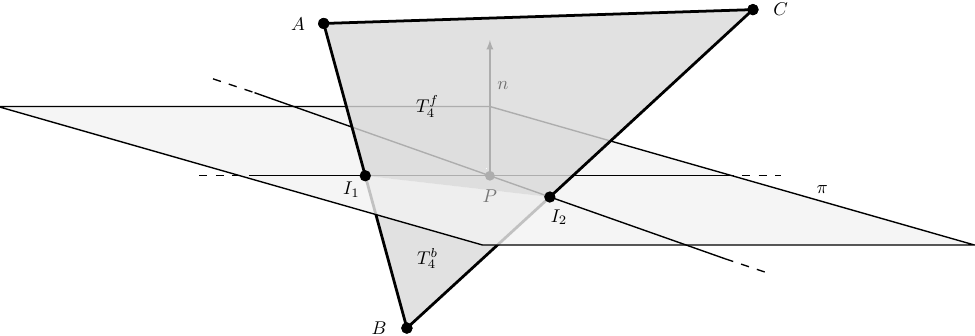
Figure 11. A triangle clipping example. The points I 1 and I 2 represent the intersections between the edges of the triangle ABC and the plane π . The trapezoid of vertices AI 1 I 2 C is considered in front of the plane, while the triangle I 1 BI 2 behind it.